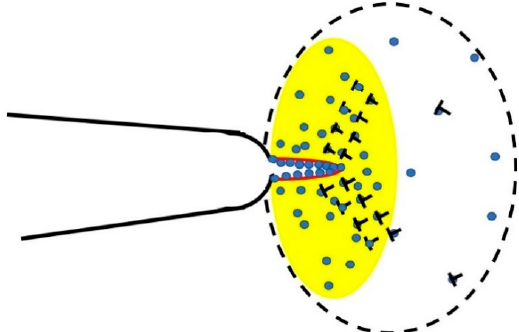
Figure 1. Schematic showing the evolution of a pre-existing microcrack; the yellow circular zone is the plastic zone where the stress is concentrated and plastic deformations (dislocations) are aggregated. The hydrogen atoms need to distribute according to the stress intensity and saturate the dislocations core (T symbols), then diffuse to the crack tip. If the atomic hydrogen concentration ahead of a crack tip approximates 1, free surfaces are generated (red). The stress intensity and dislocation density outside the plastic zone is low, hence, the hydrogen concentration outside the plastic zone approximates the bulk hydrogen concentration, c o